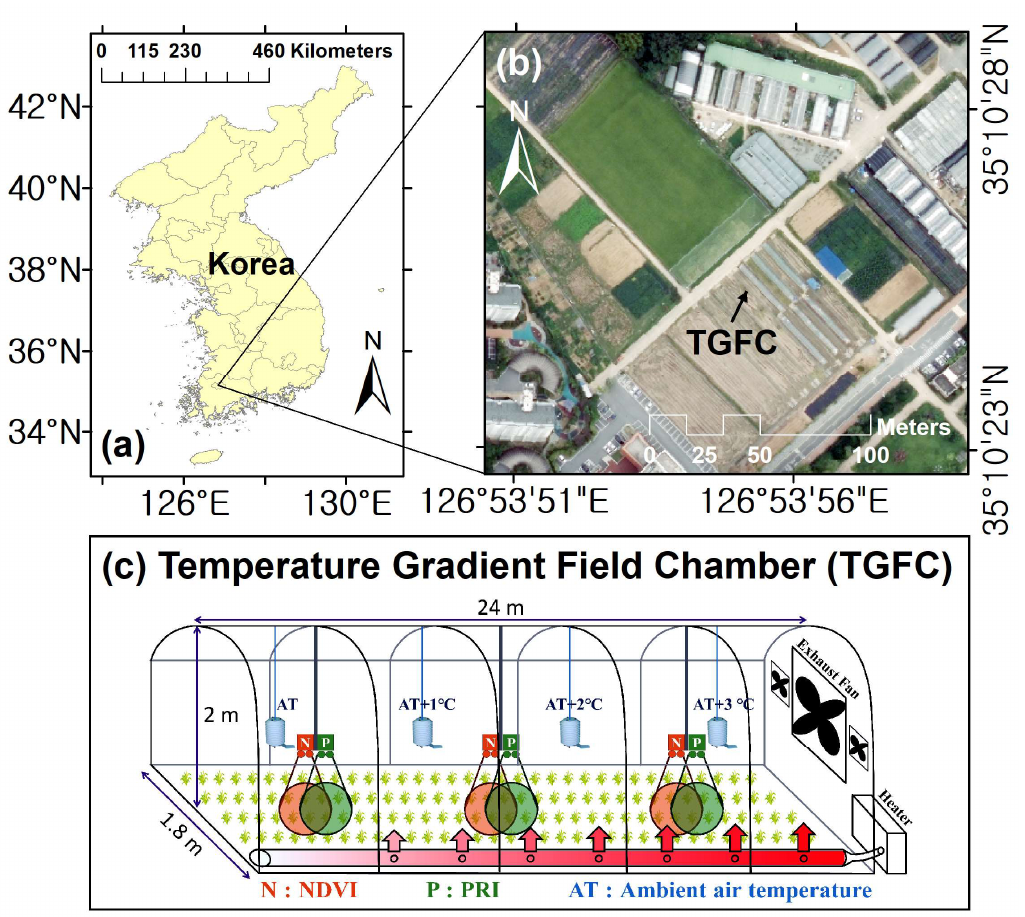
Figure 1. Study area. ( a ) Chonnam National University is located in Gwangju, Republic of Korea. ( b ) The temperature gradient field chamber (TGFC) is located in Chonnam National University. ( c ) TGFC diagram.